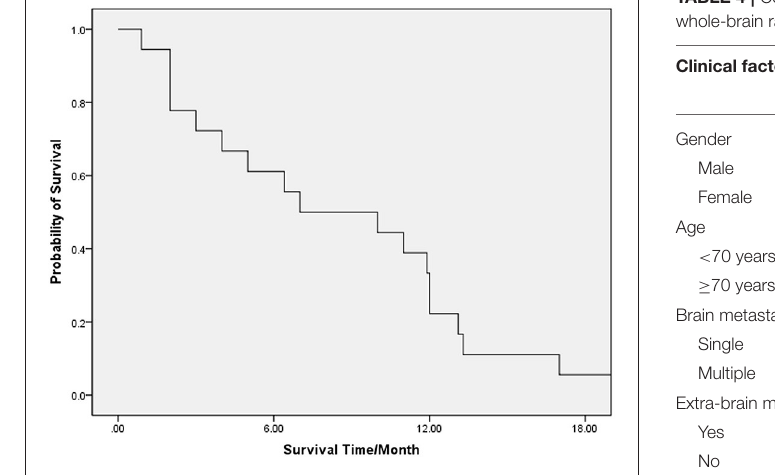
FIGURE 1 | OS for all patients.